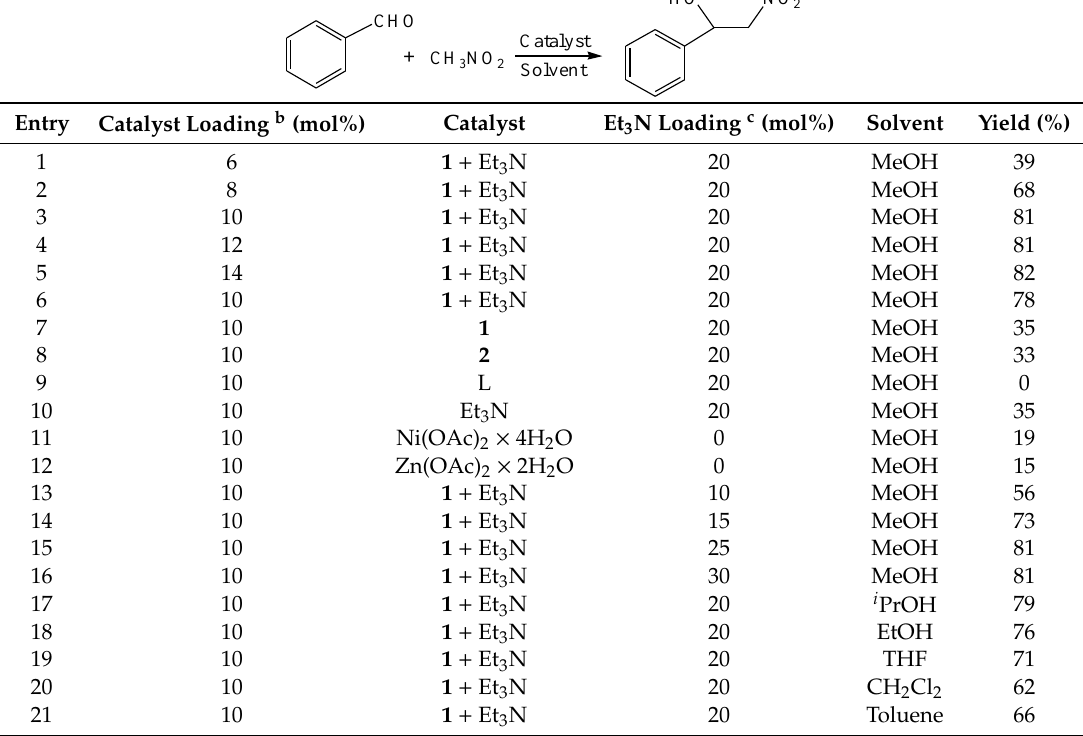
Table 1. E ff ect of di ff erent conditions on the catalytic reaction a . Table 1. Effect of different conditions on the catalytic reaction a